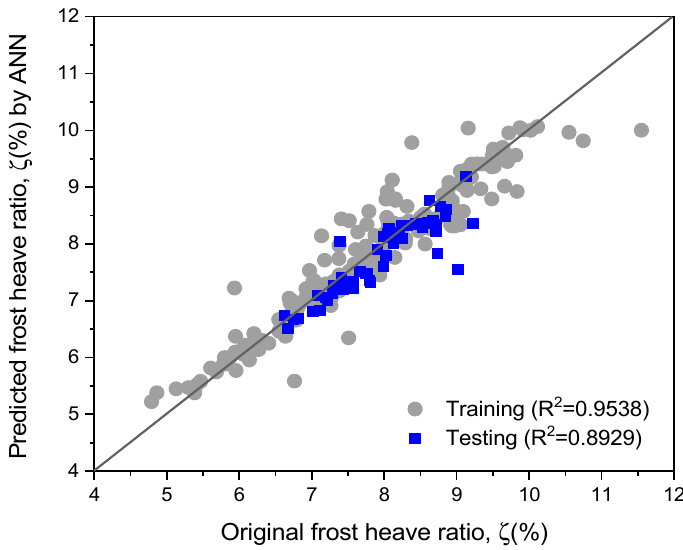
modeling error. Table 4 and Figure 11 present the weights and biases for the trained model, which ultimately allows others to make practical use of the developed ANN model.